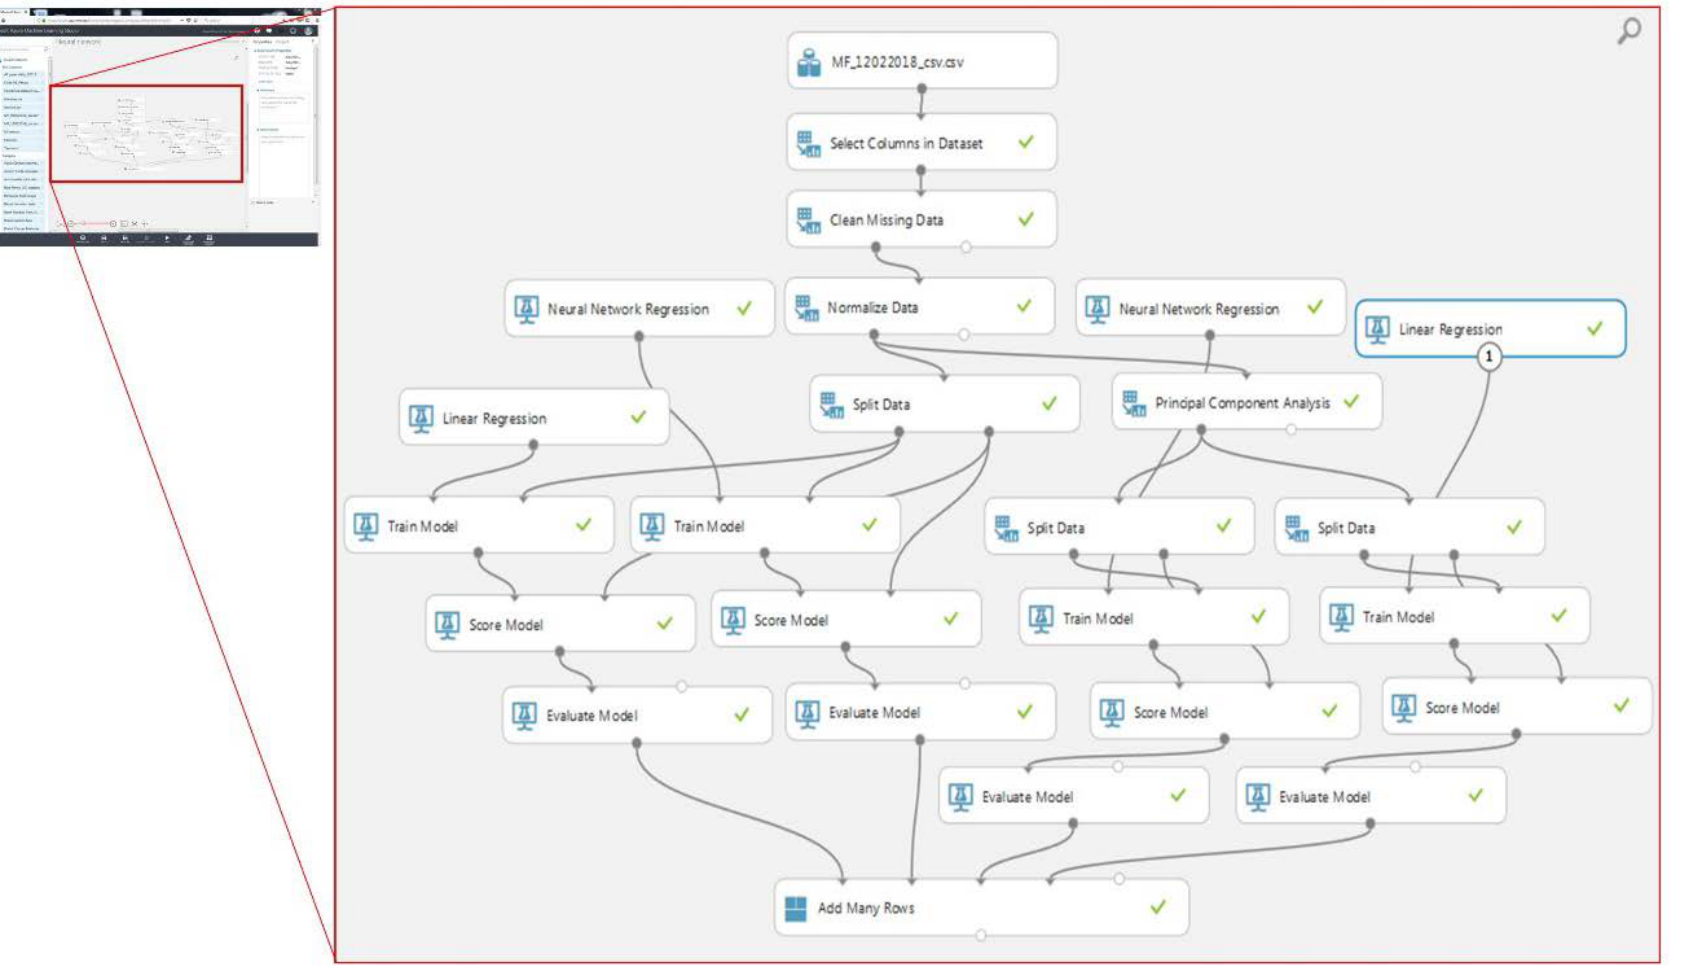
Figure 4. Prepared artificial neural network (ANN) model in Azure Machine Learning (AML) Studio.